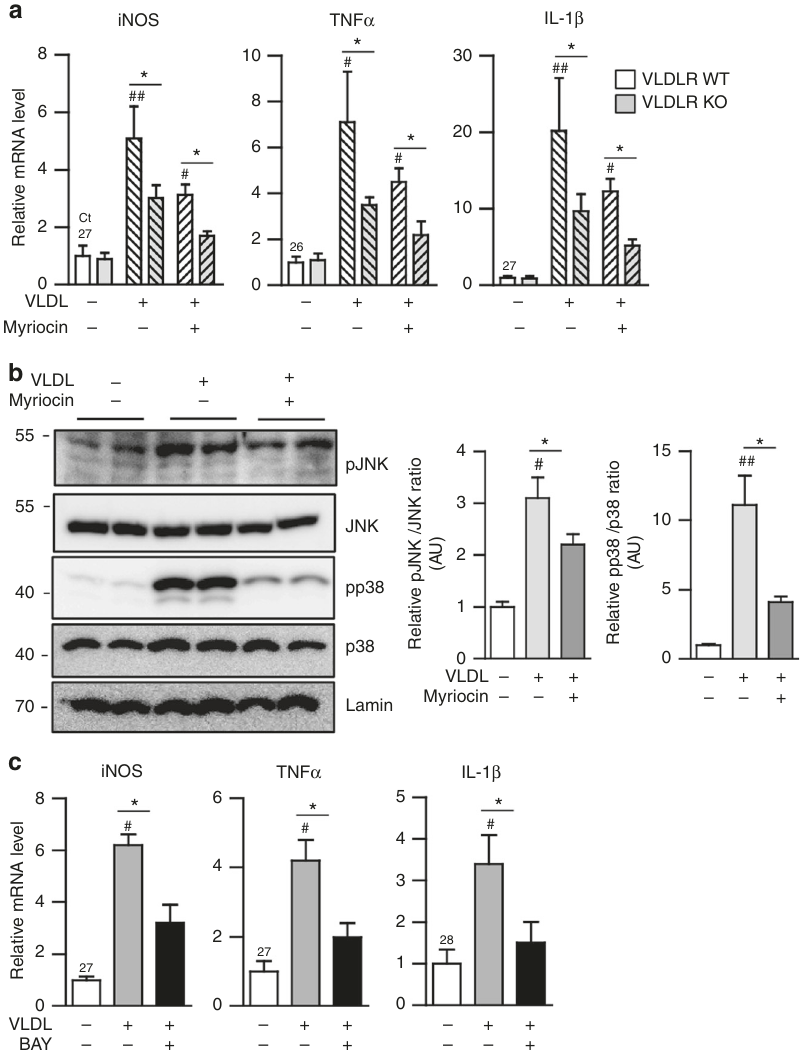
Fig. 6 MAPK pathway is involved in VLDL-induced in fl ammatory responses through ceramides. a Relative mRNA levels of pro-in fl ammatory genes in BMDMs from WT and VLDLR KO mice with human VLDL (30 μ g/ml) or myriocin (10 μ M) treatment. b Western blots of MAPK (JNK and p38) phosphorylation in BMDMs treated with or without human VLDL (30 μ g/ml) or myriocin (10 μ M). c Relative mRNA level of pro-in fl ammatory genes in BMDMs cultured with or without human VLDL (30 μ g/ml) or BAY 11-7082 (10 μ M). Each mRNA level was normalized to cyclophilin mRNA. Data represent mean ± SD. # P < 0.05 ± VLDL; ## P < 0.01 ± VLDL; * P < 0.05, Student ’ s t